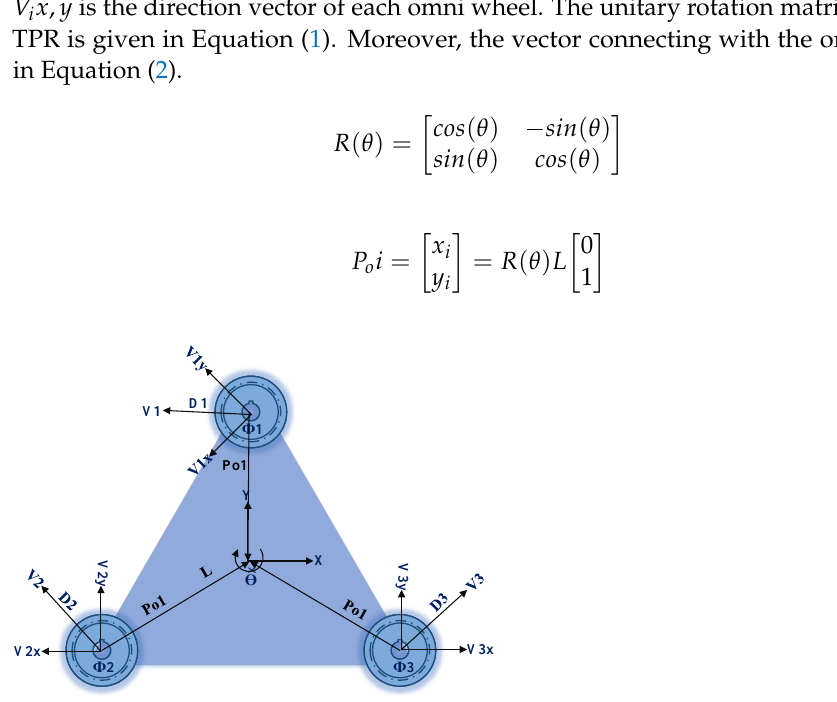
Figure 2. Kinematic model of the omnidirectional Holonomic robot. Using Equations (1) and (2), we have obtained P o 1 = L and